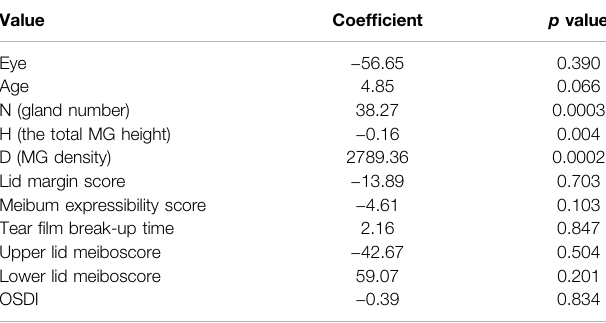
TABLE 3 | Multivariate linear regression analysis of total